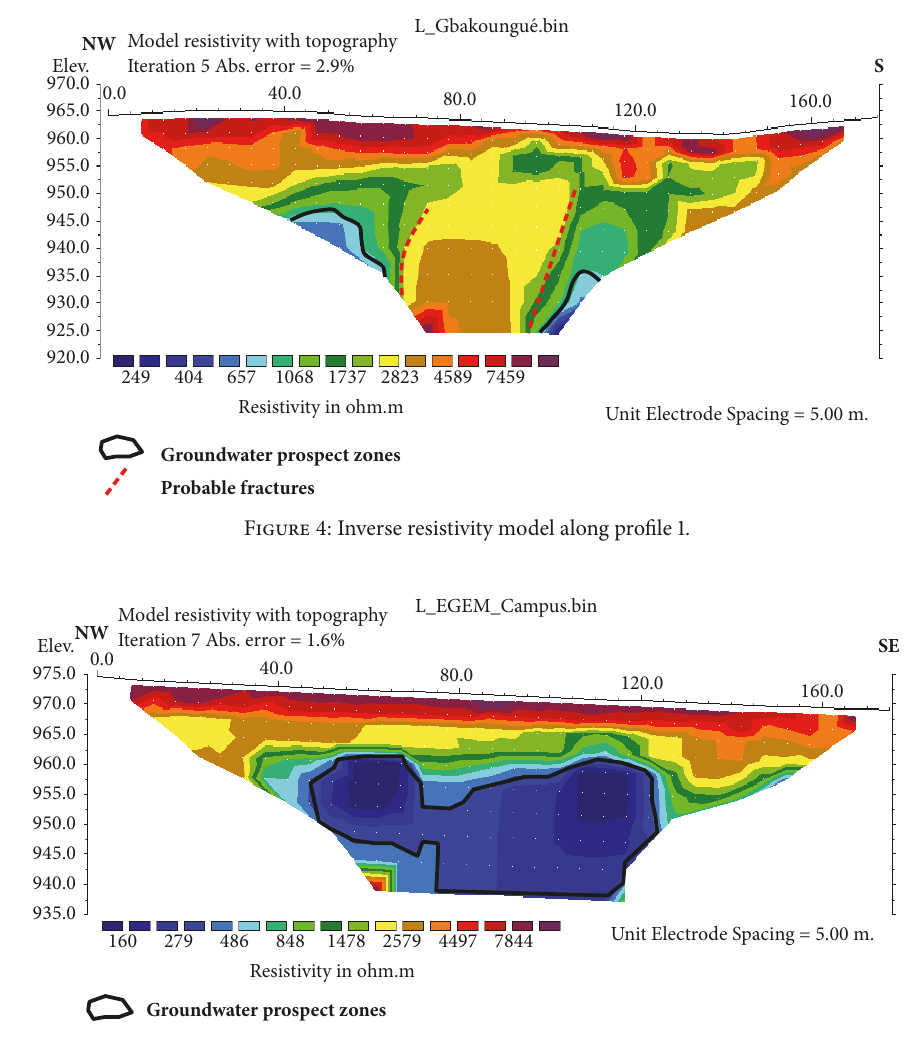
Figure 5: Inverse resistivity model along profile 2.